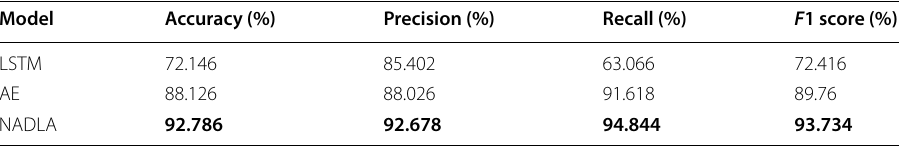
Bold indicates the performance of the NADLA model under each metric